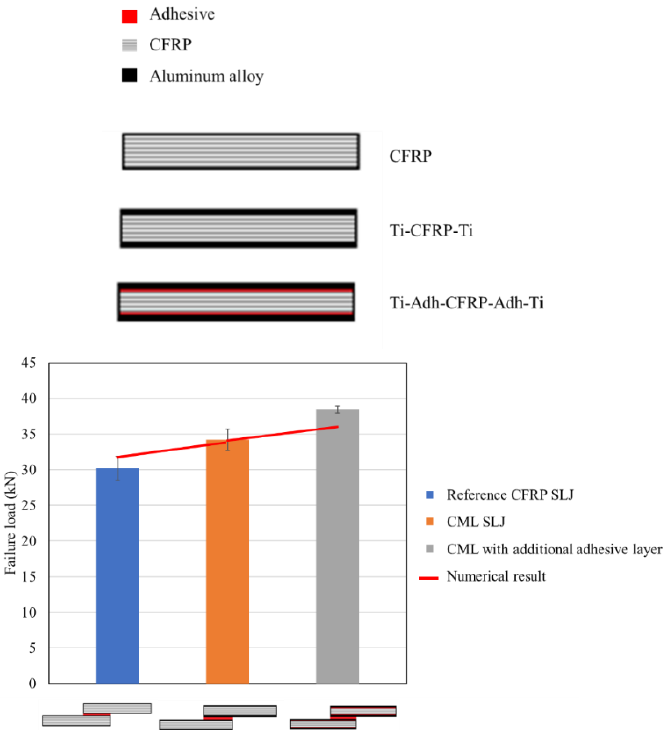
Figure 22. Failure load obtained by Santos et al. [158] for CML and CMLs with additional adhesive